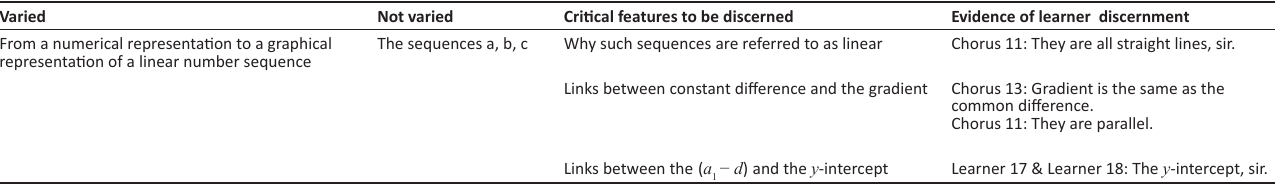
TABLE 4: Summary of discernment unit 4. Varied Not varied Critical features to be